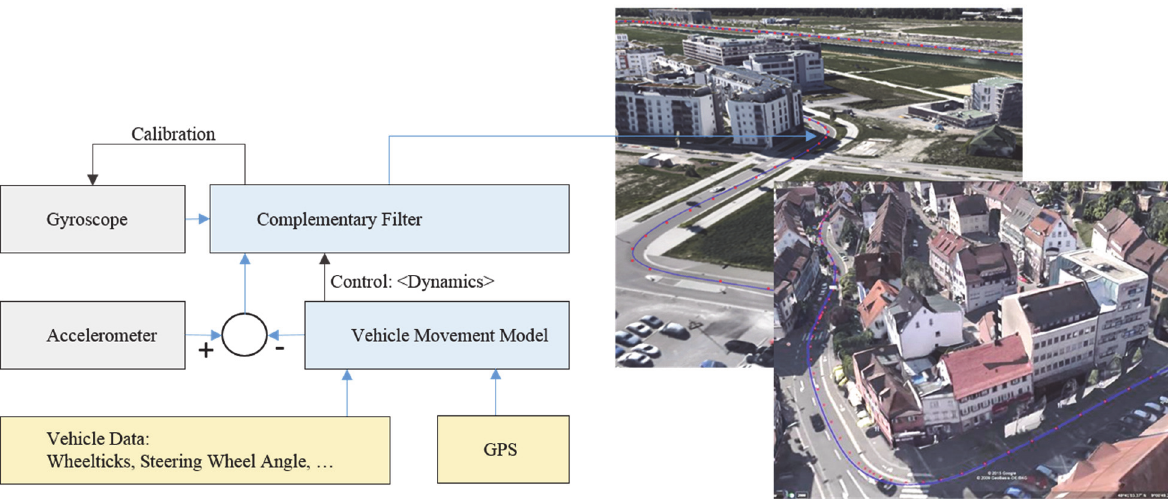
Fig. 4 Sensor fusion data flow for in-vehicle pose estimation (left). Visualization of pose data (blue line) and raw GPS data (red dots) are in Google Earth (right). Based on vehicle data and GPS information, the lowest layer of the algorithm determines forces expected from the vehicle movement. Real forces, which affect the vehicle body, are measured using an accelerometer. This accelero- meter is part of a standard in-vehicle state of the art MEMS combined inertial sensor, capable of detecting acceler- ation and angular rates in three perpendicular axes (a-xyz, Ω